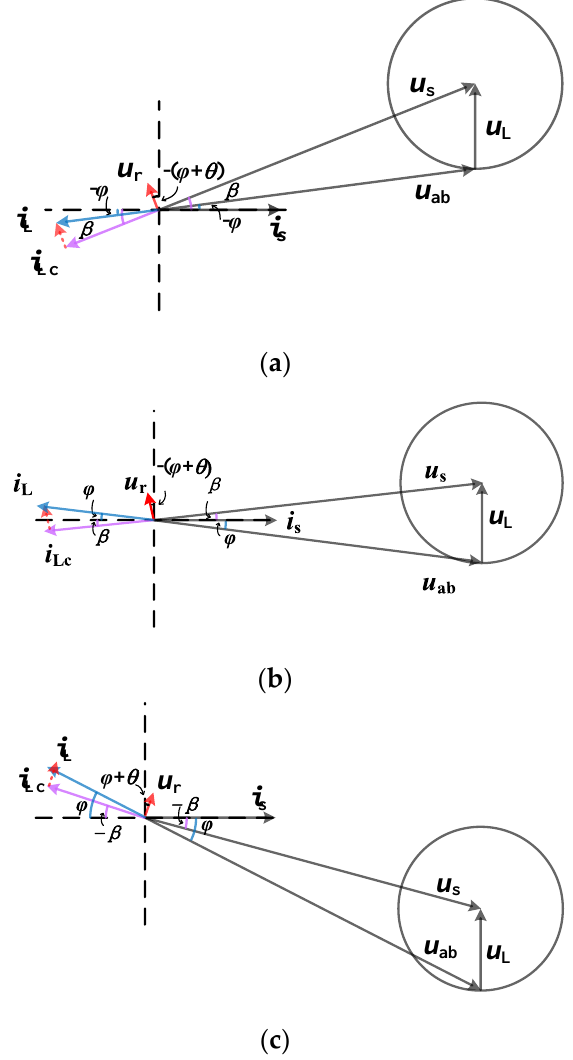
Figure 5. Phasor diagram of different variables in the rectifier: ( a ) Case 1 in quadrant I, the angle between u L and u ab is acute; ( b ) Case 2 in quadrant I, the angle between u L and u ab is obtuse; and ( c ) Quadrant II.